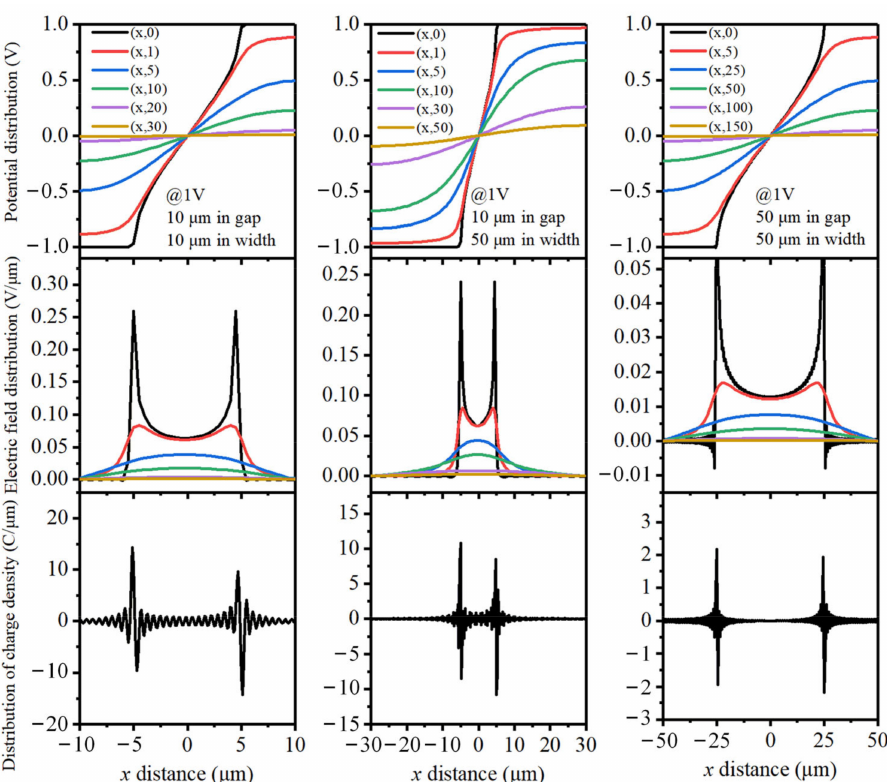
Figure 2. Electric potential V a ( x , y ), electric field E a ( x , y ), and surface charge σ ( x ) distributions on IDE with different gaps and widths at various heights (distance from the electrode surface in the